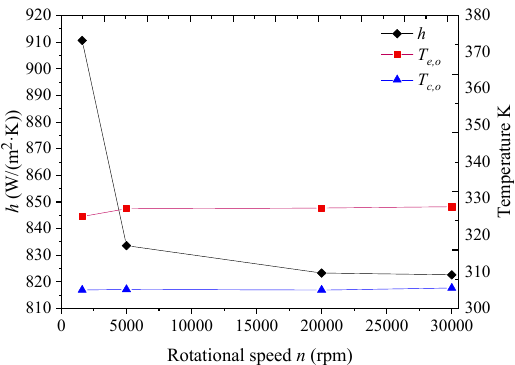
Figure 7. Heat transfer performance under different rotational speeds. Energies 2020 , 13 , x FOR PEER REVIEW